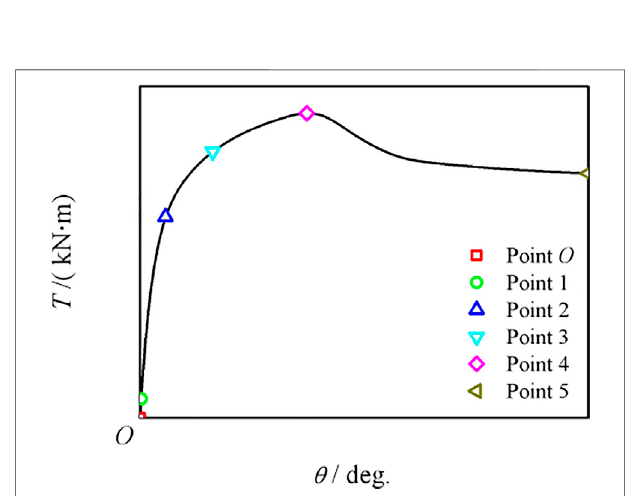
FIGURE 18 | Typical T – θ curve of C-CF-CFRP-ST compression torsion members.